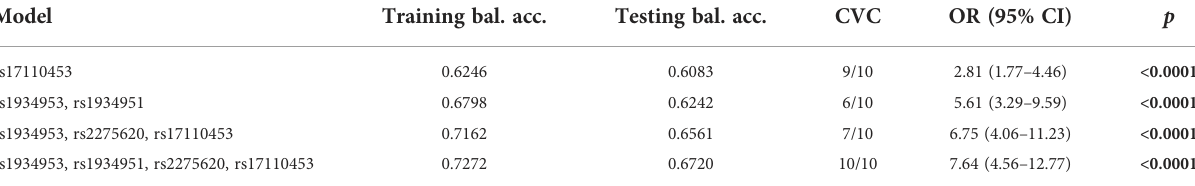
p-values were calculated by c 2 test. p <0.05 indicates statistical signi fi cance. Bal. Acc., balanced accuracy; CVC, cross-validation consistently. The bold values mean statistically signi fi